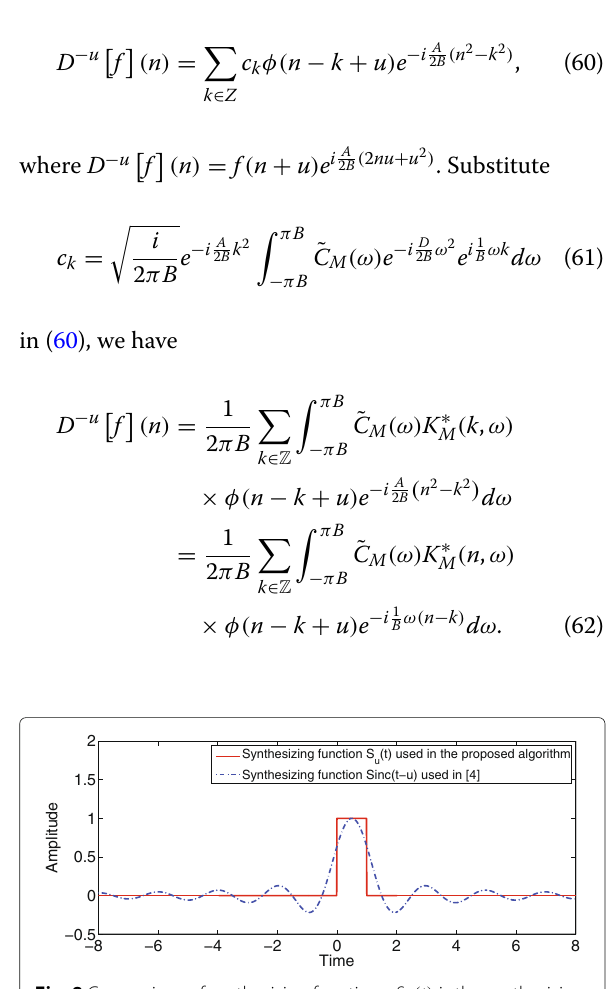
Fig. 8 Comparison of synthesizing functions: S u ( t ) is the synthesizing function used in the proposed algorithm, while Sinc ( t − u ) is the synthesizing function used in